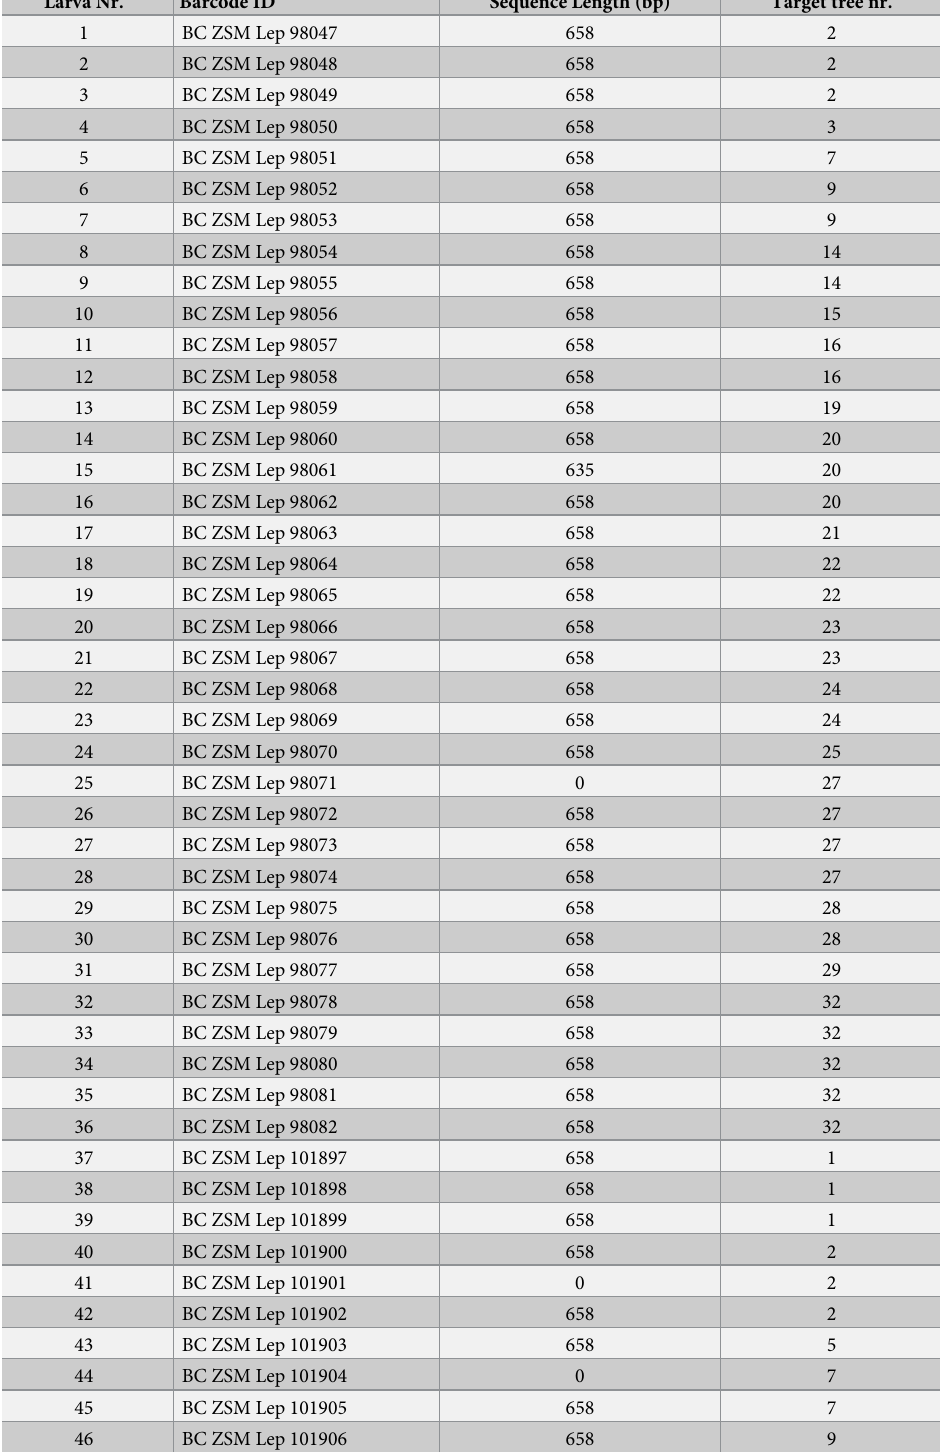
Table 1. Overview on the 130 Lepidoptera larvae selected from 36 fogging samples from Panguana, Peru, sequencing success and number of target tree. Larva Nr. Barcode ID Sequence Length (bp) Target tree